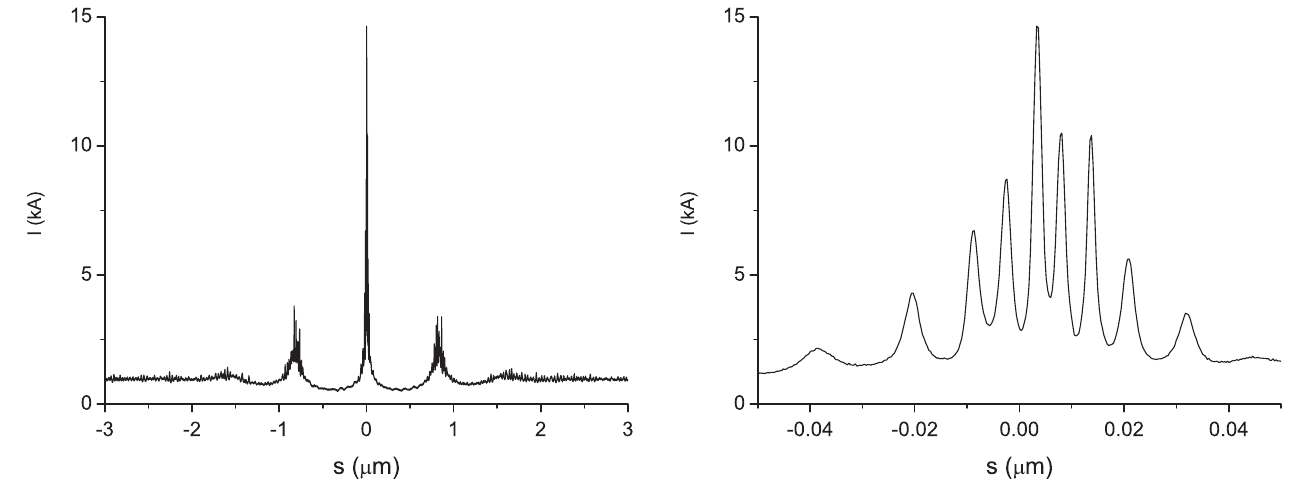
FIG. 8. Central part of the electron bunch (left) and a zoomed high-current part (right) after compression in the fourth chicane. The calculations were performed with LOSCA .